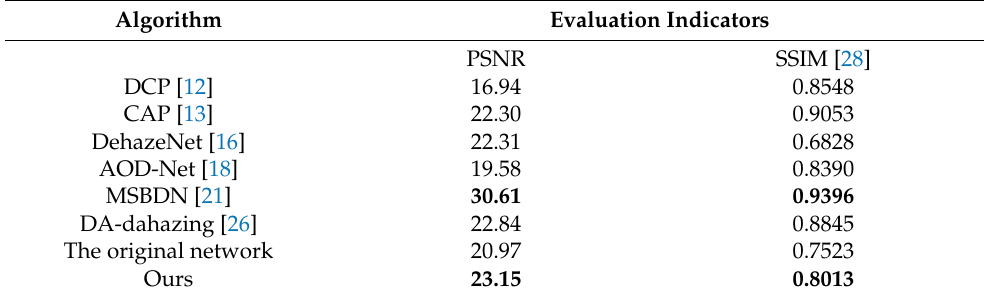
Table 2. Comparison of our algorithm and other algorithms on the objective indicators of the dehazing results on the SOTS dataset. Bold texts are the best and our experimental